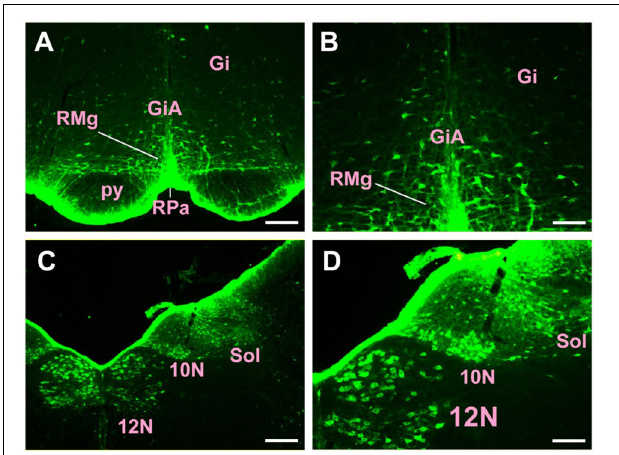
FIGURE 7 | The distribution of neurons labeled by CB in the medulla oblongata Part II (A–D) . Gi, gigantocellular reticular nucleus; GiA, gigantocellular reticular nucleus alpha part; RMg, raphe magnus nucleus; RPa, raphe pallidus nucleus; py, pyramidal tract; 10N, dorsal motor nucleus of vagus; 12N, hypoglossal nucleus; Sol, solitary nucleus. Scale bar = 100 µ m.